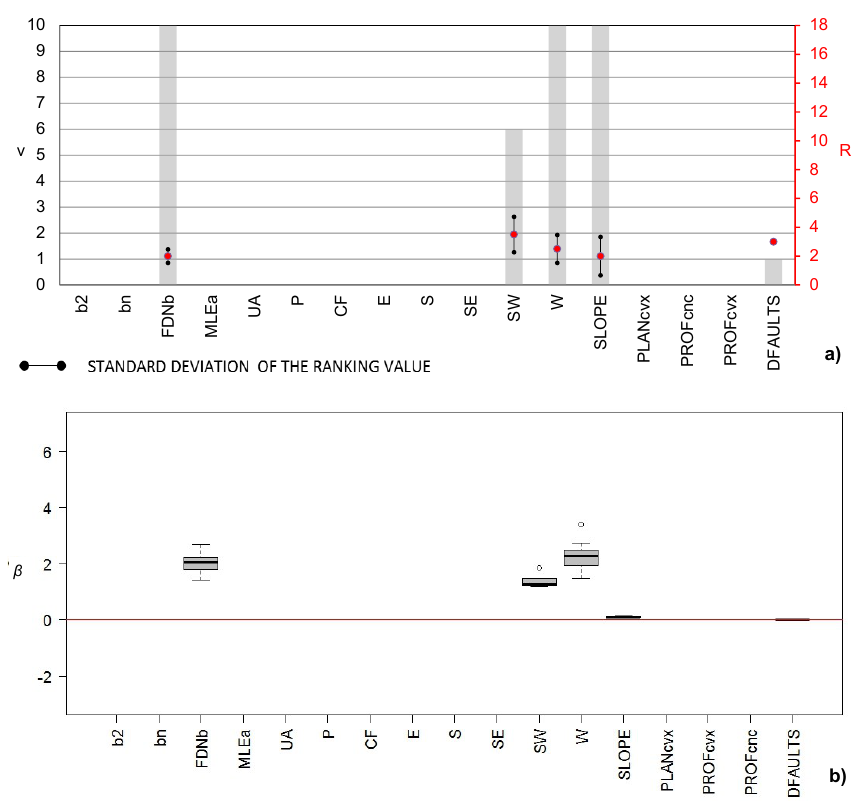
Figure 9. Selected variables for the 2007 suite of models: (a) ranking and frequency; (b) β